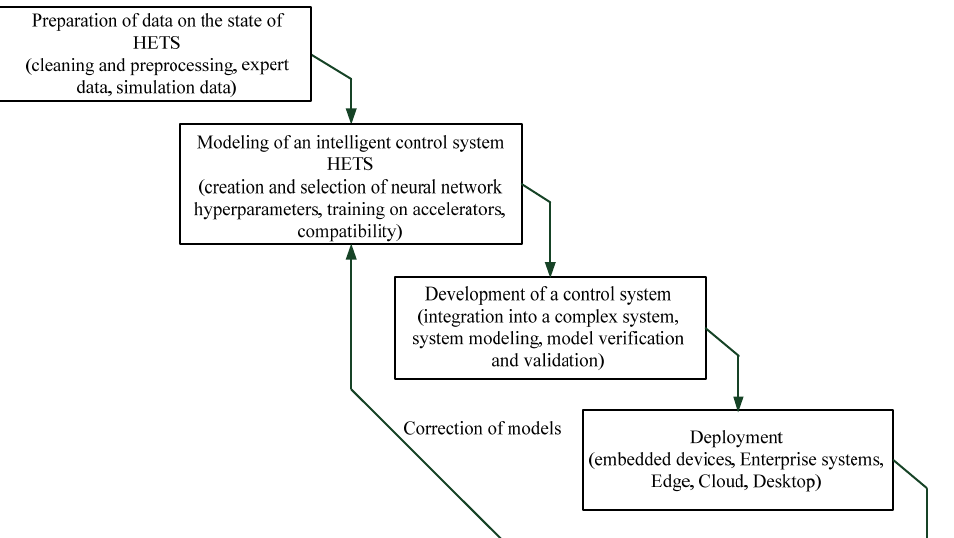
Figure 7. The sequence of stages in developing an intelligent control system for CETS.